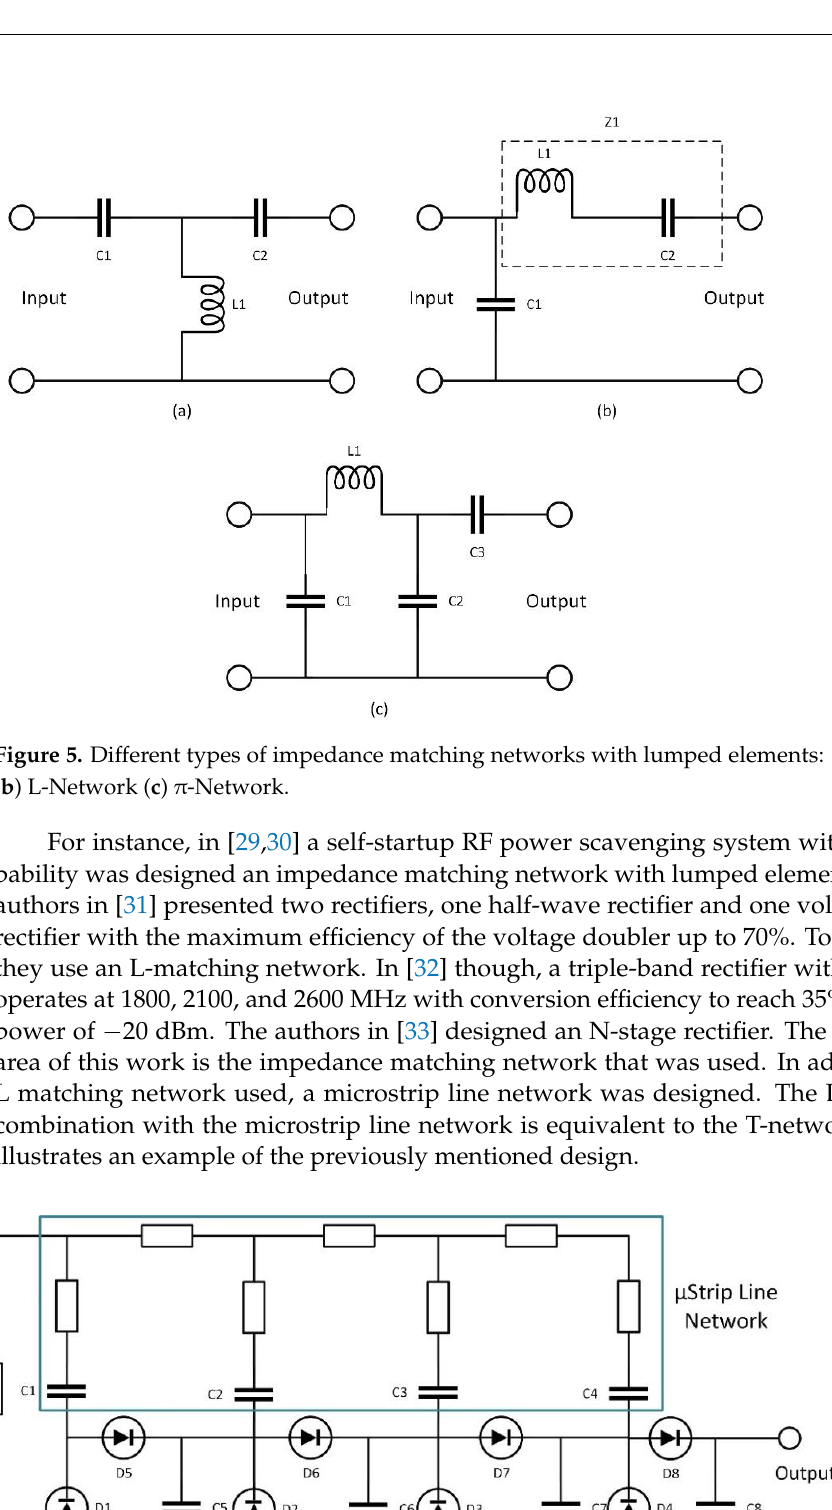
Table 2. Different types of Impedance Matching Networks.